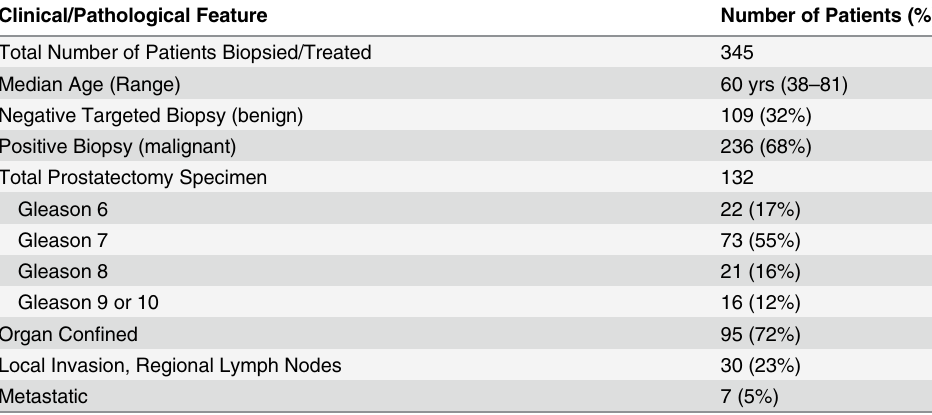
Table 1. Clinical/pathological features of patient group